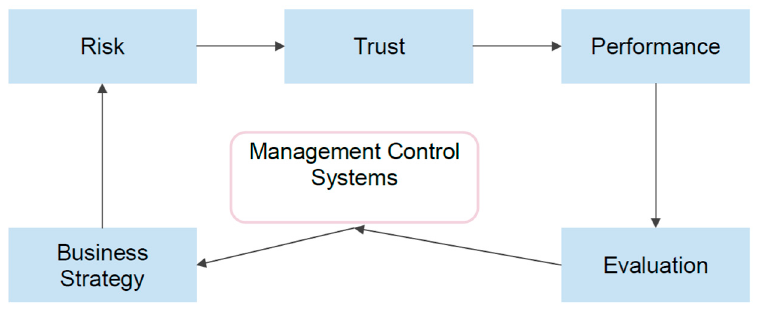
Figure 1. Description of the relationship between the proposed concepts. Source: Authors.